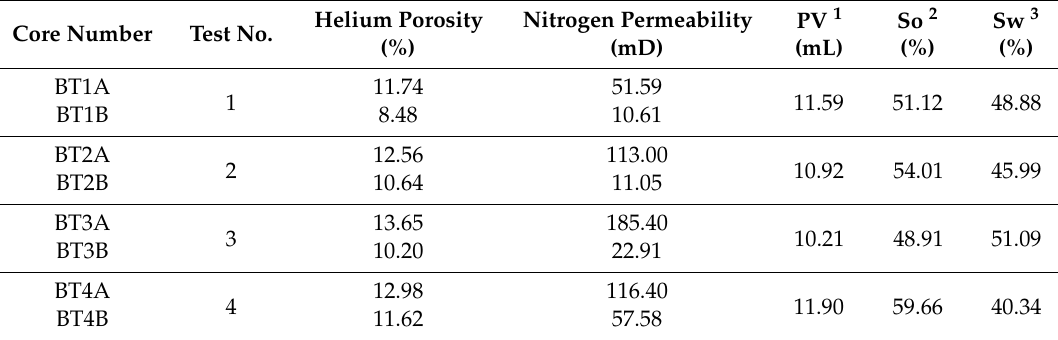
Table 6. Data of Guelph Dolomite core plugs used in core flooding